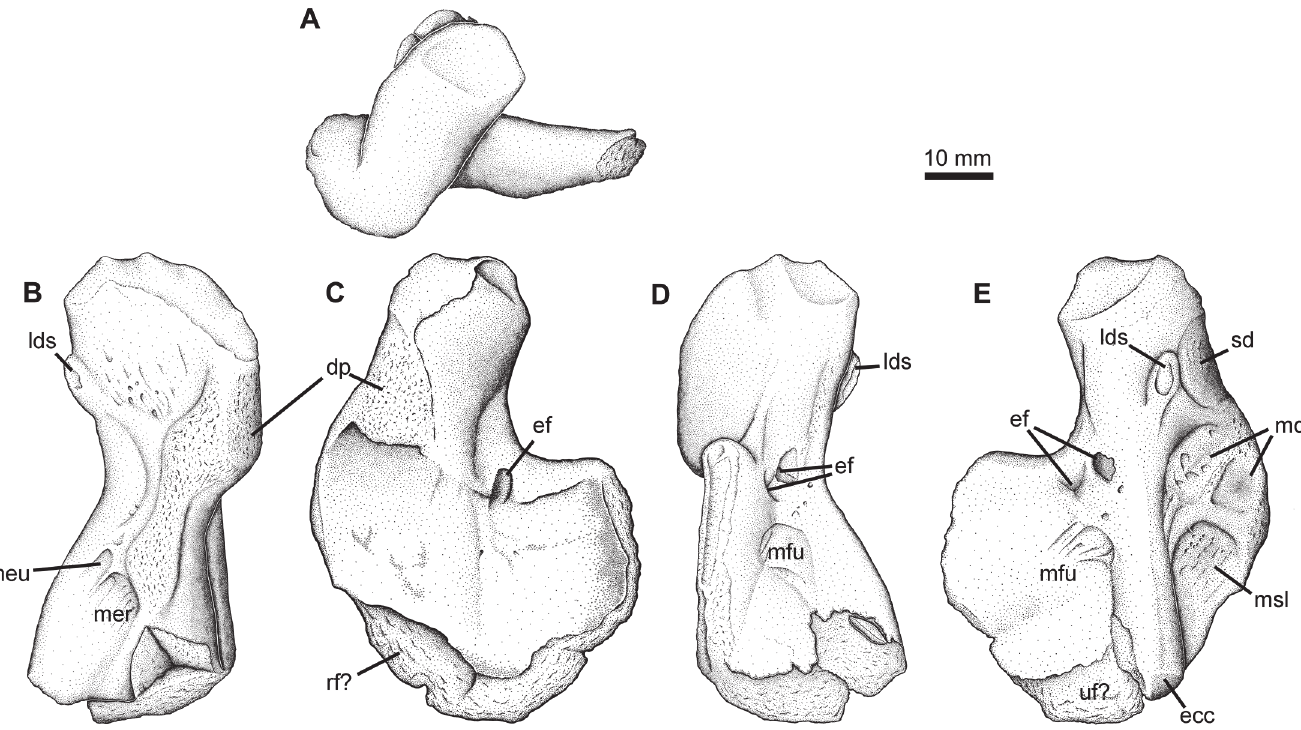
Fig 4. Humerus Type 1. NSM005GF045.037, right humerus in A, proximal, B, anterior, C, ventral, D, anterior, and E, dorsal views. Abbreviations : dp , deltopectoral crest; ef , entepicondylar foramen; lds , latissimus dorsi spike; md , m. deltoideus scar; mfu , m. flexor ulnaris scar; mer , m. extensor radialis scar; meu , m. extensor ulnaris scar; msl , m. supinator longus scar; rf , radial facet; sd, scapulhumeral depression; uf , ulnar